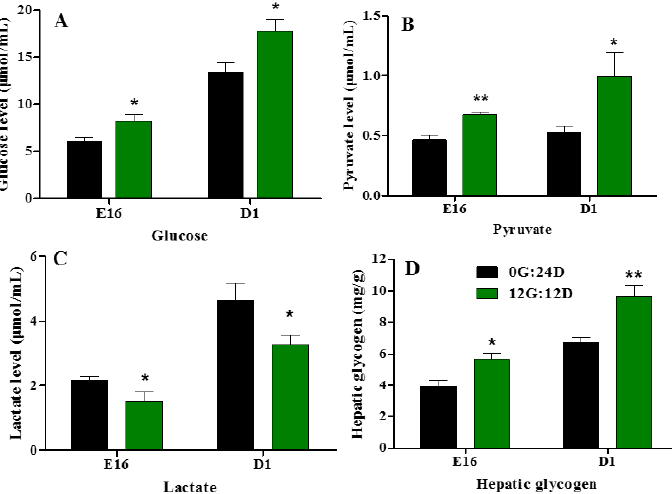
Figure 8. Plasma glucose, pyruvate and lactate levels of goose embryos incubated in the dark or under monochromatic green light. ( A ) Plasma glucose levels. ( B ) Plasma pyruvate levels. ( C ) Plasma lactate levels. ( D ) Hepatic glycogen levels. Data are presented as mean ± SEM (n = 8 embryos per group). Means with asterisks show significant difference between the 2 groups on the same day (* p < 0.05, ** p < 0.01.).